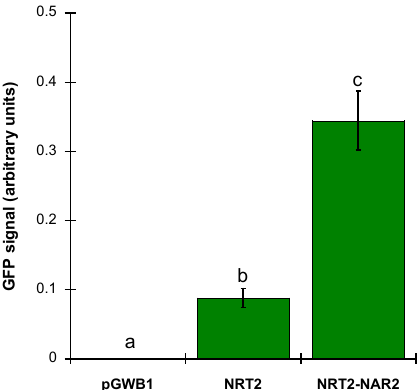
Figure 4. ZosmaNRT2-GFP fluorescence intensity. GFP signal level was calculated as RAW integrated density of fluorescence images of N. benthamiana epidermal leaf cells transiently transformed with empty vector pGWB1 (Control), 35S::ZosmaNRT2-GFP (NRT2) or coexpressing 35S::ZosmaNRT2-GFP and 35S::ZosmaNAR2 (NRT2-NAR2). ImageJ was used to quantify the GFP signal levels. Data are mean ±SD of four independent experiments. Different letters indicate significant differences (Tukey Test, p < 0.0001).